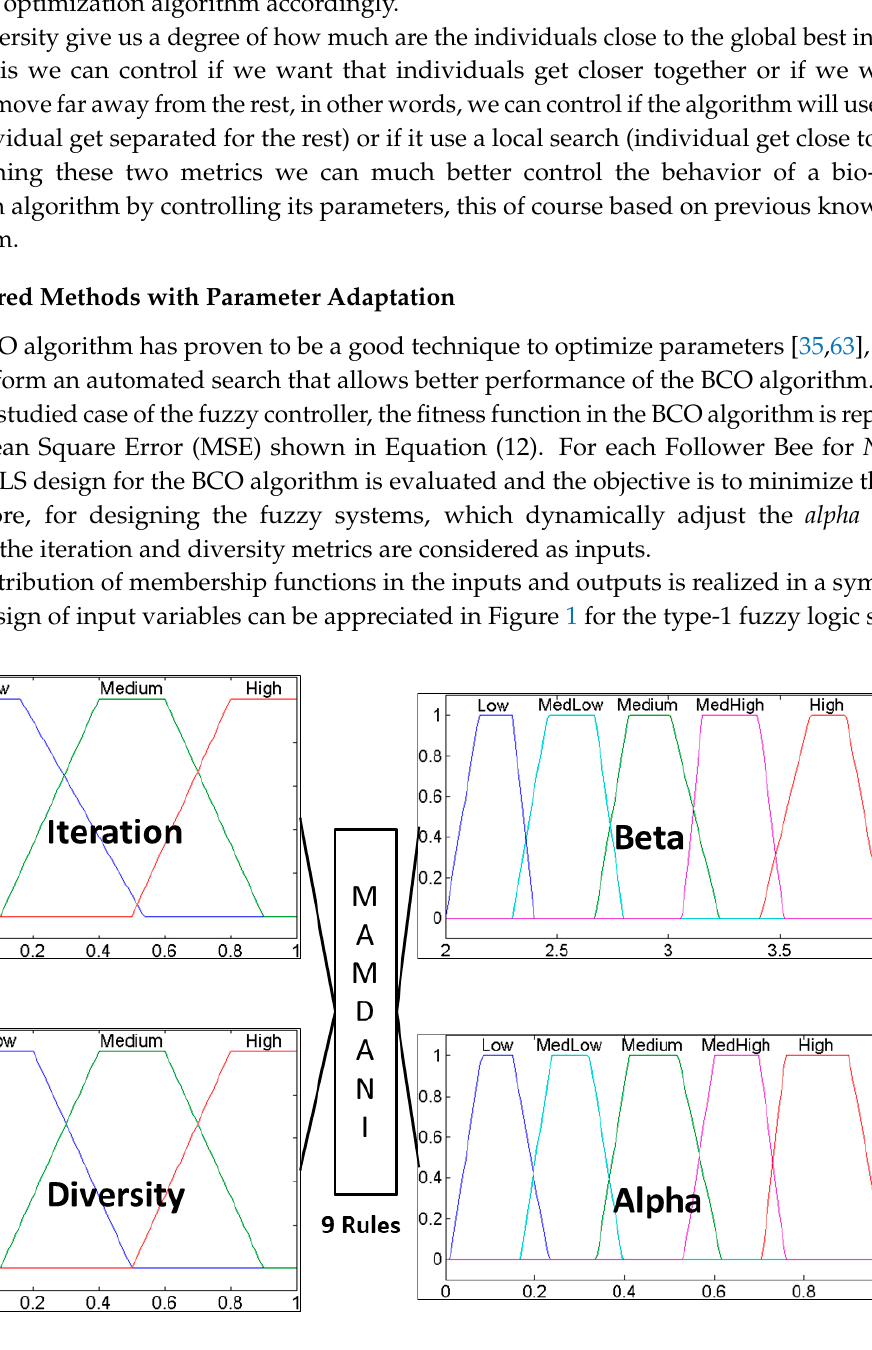
Figure 1. Type-1 fuzzy system for dynamic parameter adaptation in BCO (Bee Colony Optimization).